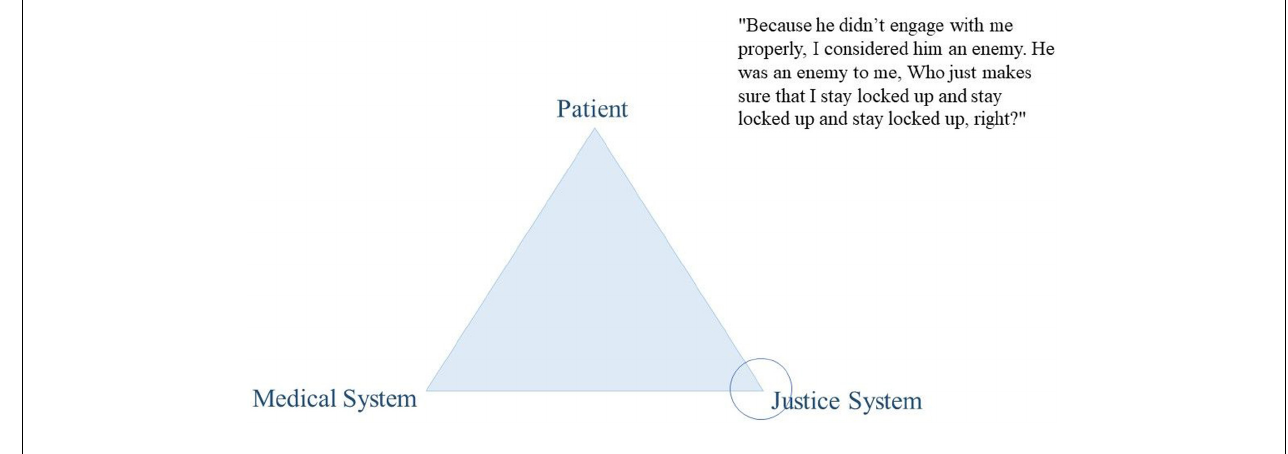
FIGURE 2 | Citation of participant D438.